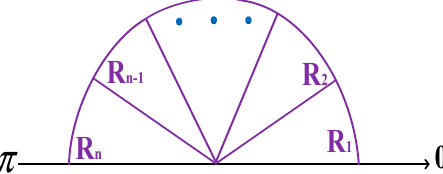
Figure 3. Improved orientation partition scheme.